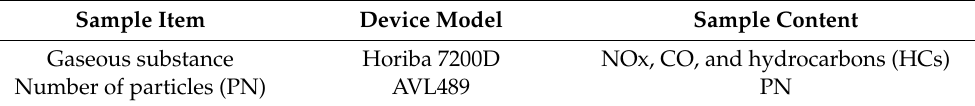
Table 3. Sampling equipment and